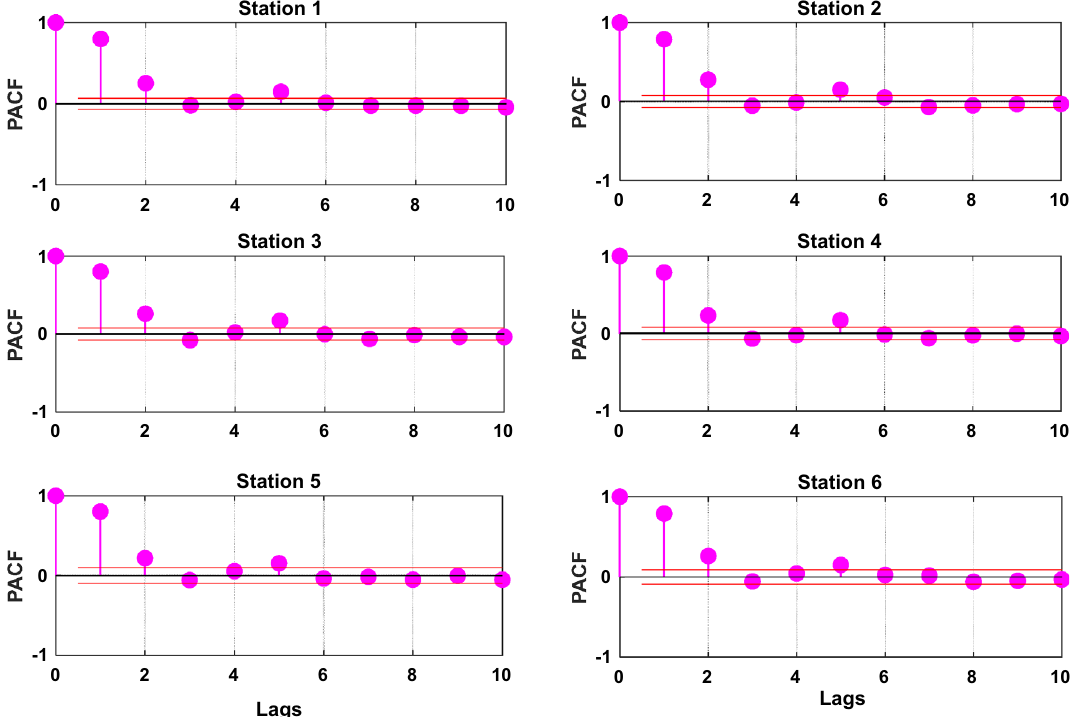
Figure 5. Partial autocorrelation function correlation coefficient (PACF) of the historical annual wheat yield time series for each testing study station: Station 1: Rahimyar Khan, Station 2: D. G. Khan, Station 3: Kasur, Station 4: Sialkot, Station 5: Rawalpindi, and Station 6: